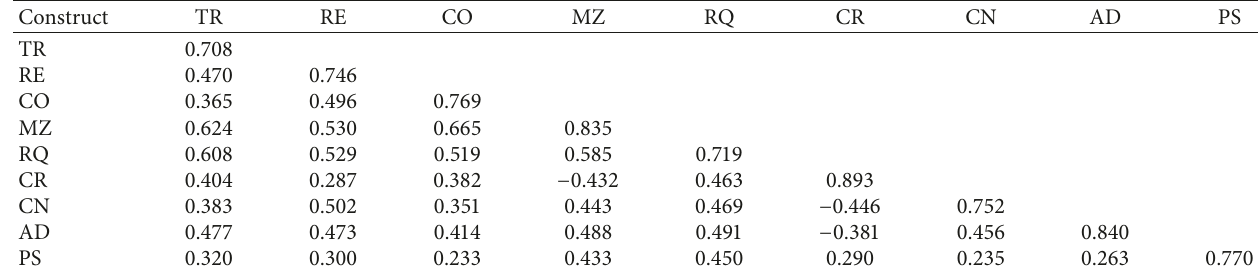
Table 4: Correlations of latent variables and evidence of discriminant validity.